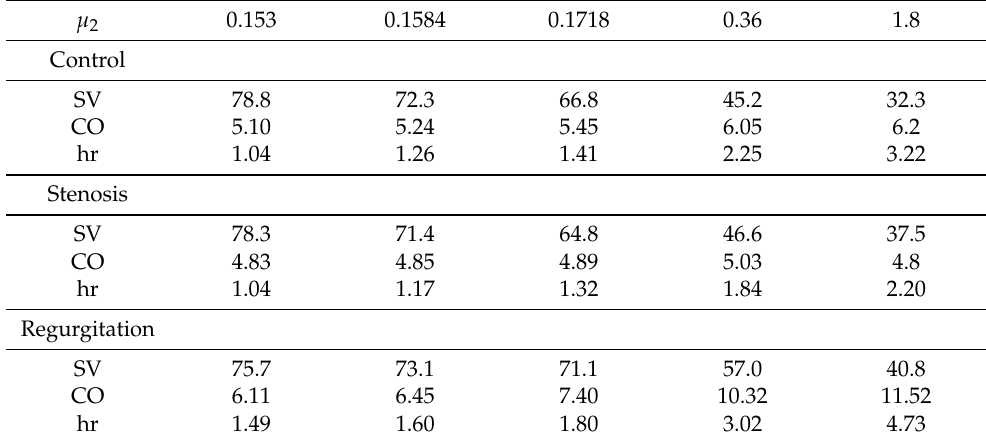
Table 7. Effect of µ 2 with a severe mitral valve stenosis or